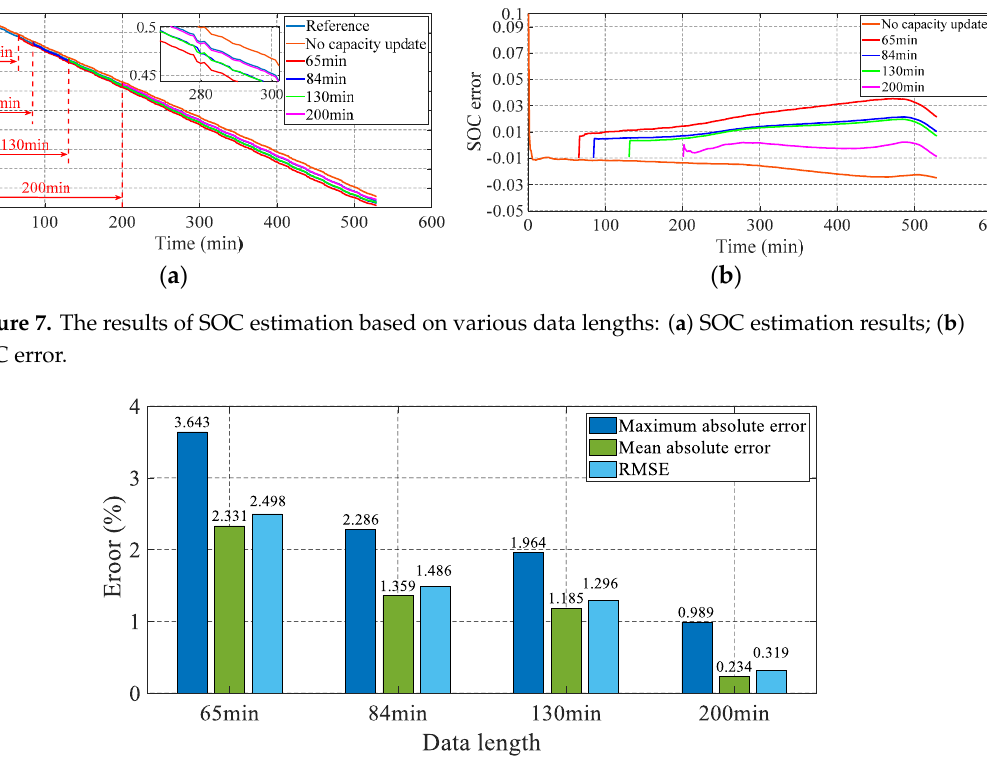
Figure 8. Comparison of the battery SOC estimation results of different data lengths.